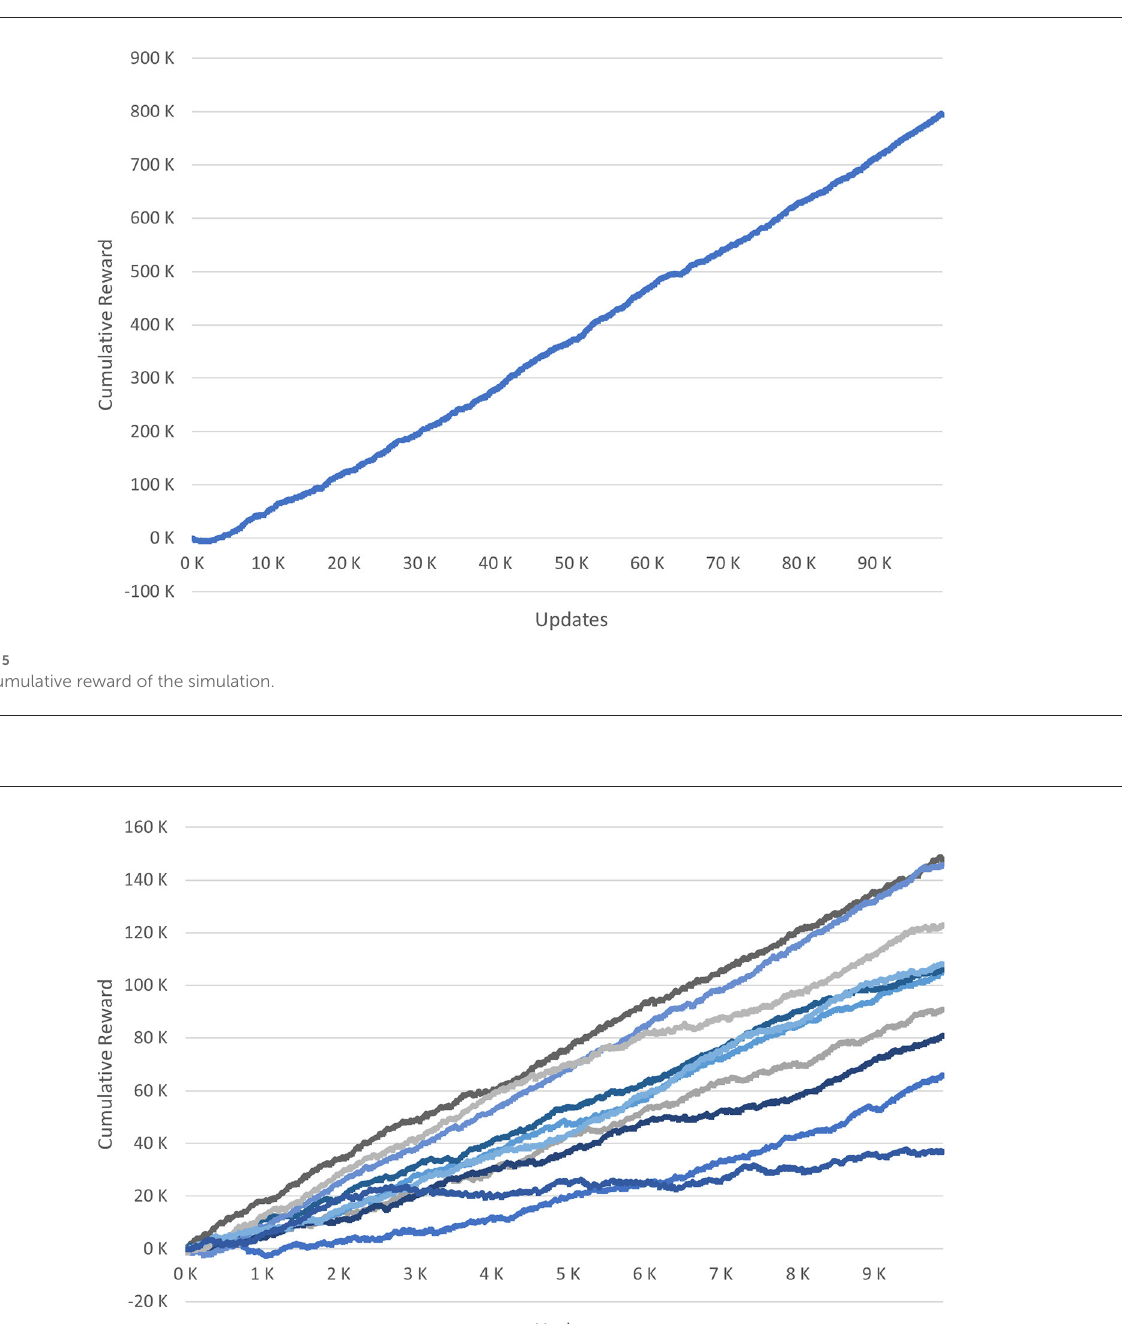
of the best possible action. We define a normalized regret as normalizedregret = regret ( executedaction ) / regret ( worstaction ) whereas the worst action the one with the highest regret is. As a result, the normalized regret stays between 0 (best possible action) and 1 (worst possible action). Figure 7 shows